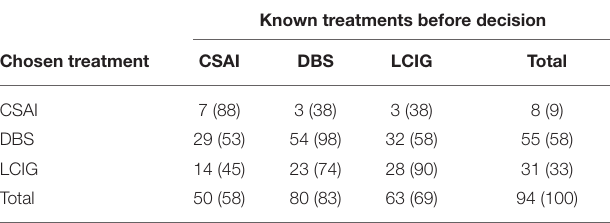
TABLE 3 | Degree of known advanced treatment